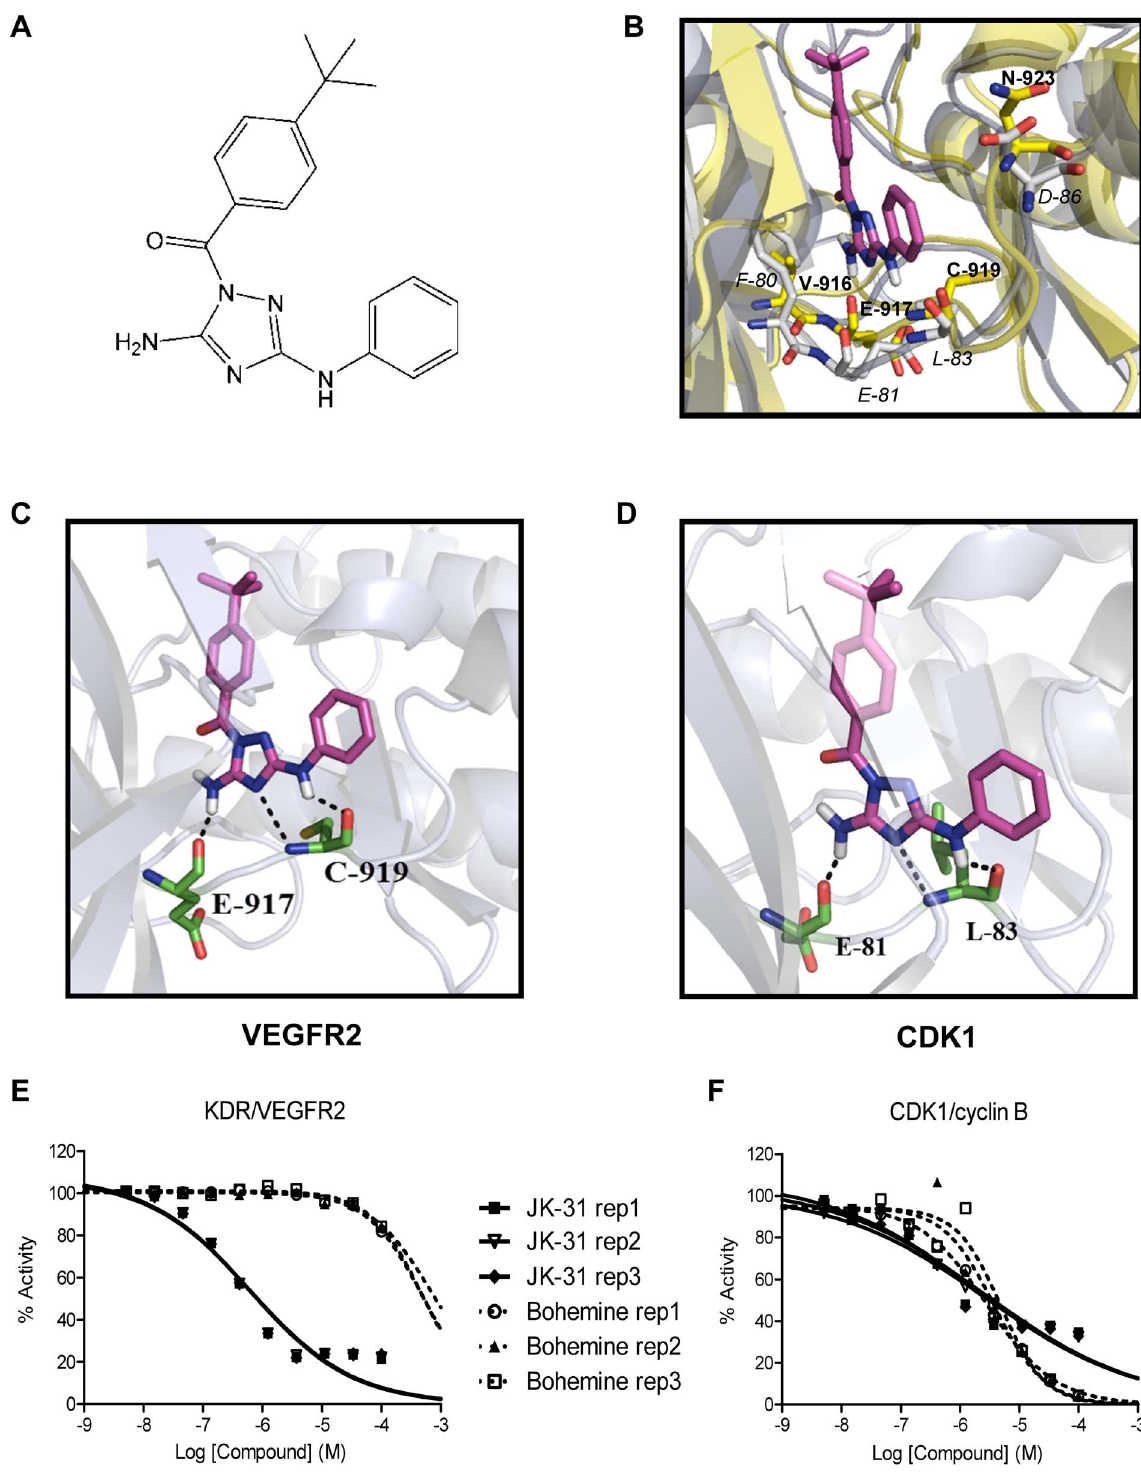
Figure 1. Dual targeting of VEGFR2 and CDK1. (A) Chemical structure of the aminotriazole-based compound JK-31. A full description of the chemical synthesis can be found in the Materials and Methods section. (B) In silico molecular modeling of JK-31 (magenta structure) in the VEGFR2 and CDK1 kinase domains. A homology model of CDK1 was created using a structurally-related family member (CDK2 PDB code: 3s2p). The CDK1 and VEGFR2 kinase domain sequences were aligned and overlapped. JK-31 was docked into the overlapped crystal structure using Glide program and important amino acid residues identified. VEGFR2 crystal structure is shown in yellow and residues annotated in bold; CDK1 crystal structure is shown in blue/grey and residues annotated in italics. (C) JK-31 was docked into a VEGFR2 crystal structure alone (PDB code: 3cjg) and predicted hydrogen bond contacts identified. (D) JK-31 was docked into the CDK1 crystal structure homolog alone and predicted hydrogen bond contacts identified. Dotted lines denote predicted hydrogen bond contacts. Green structures denote important kinase domain residues. Further details of these models